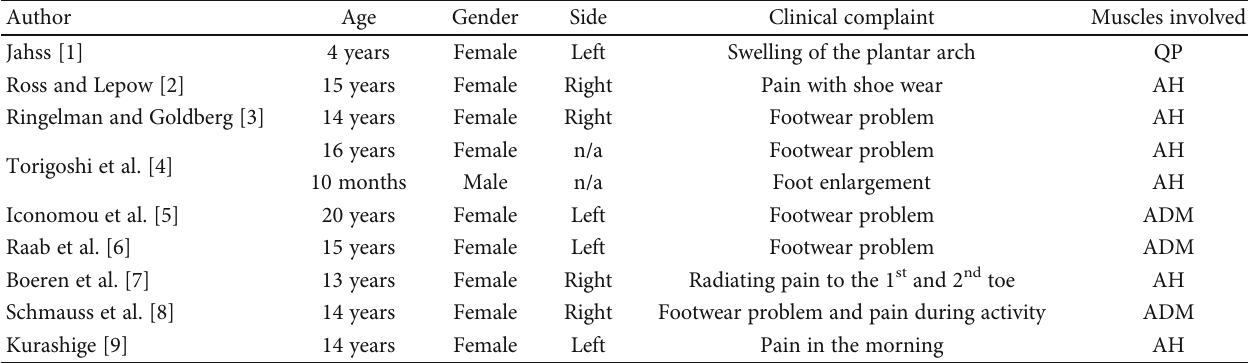
Table 1: Literature review of previous cases concerning congenital unilateral hypertrophy of an isolated plantar muscle.